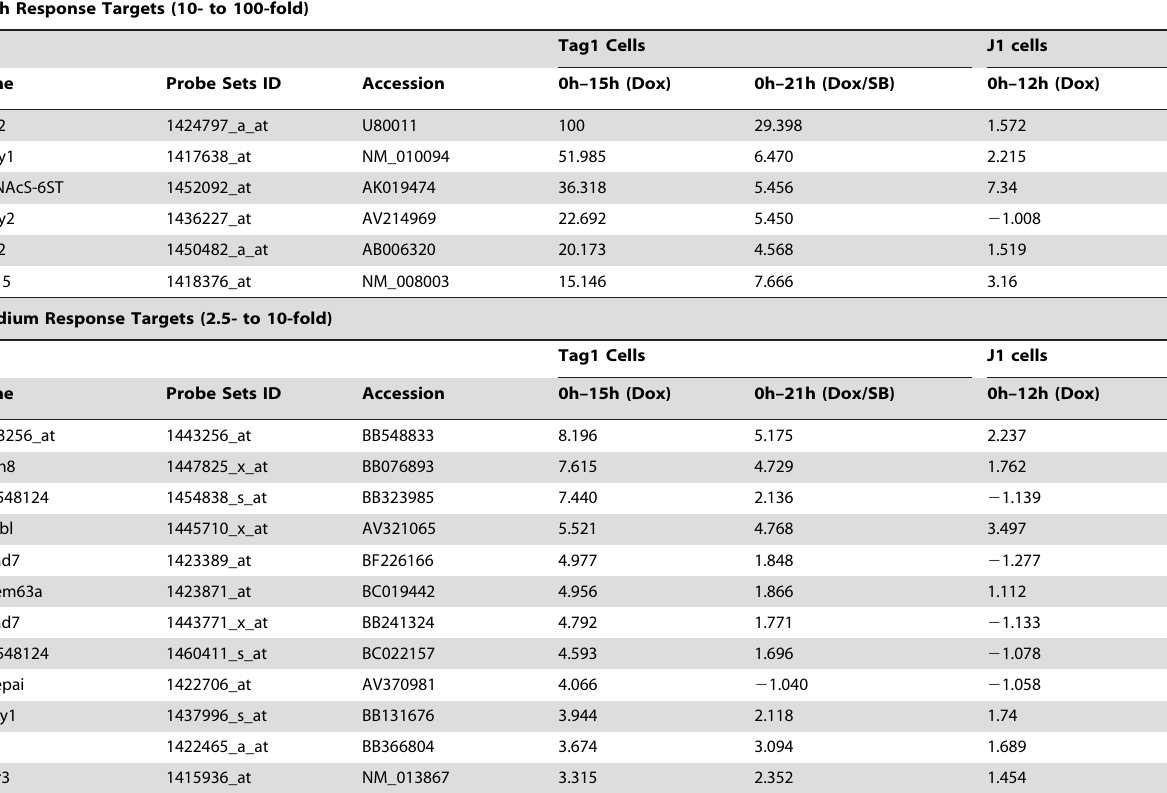
High Response Targets (10- to